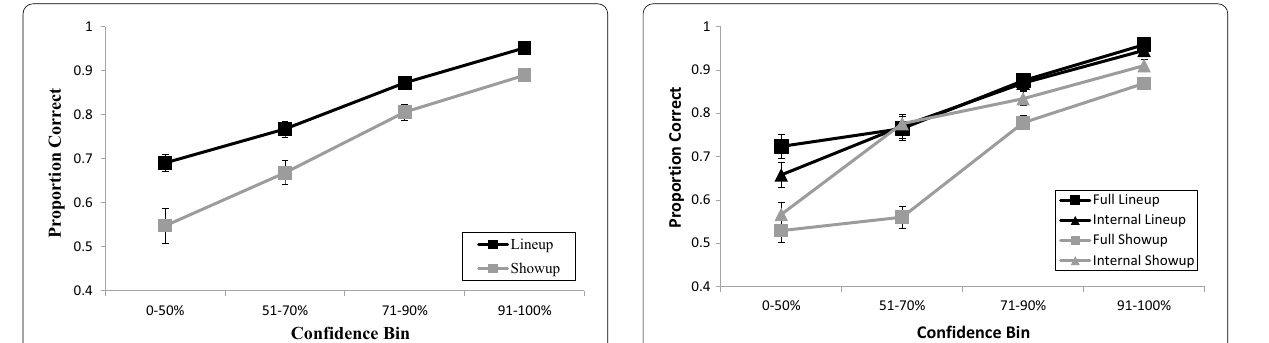
Fig. 11 Overall CAC curve for lineups versus showups, with standard error bars